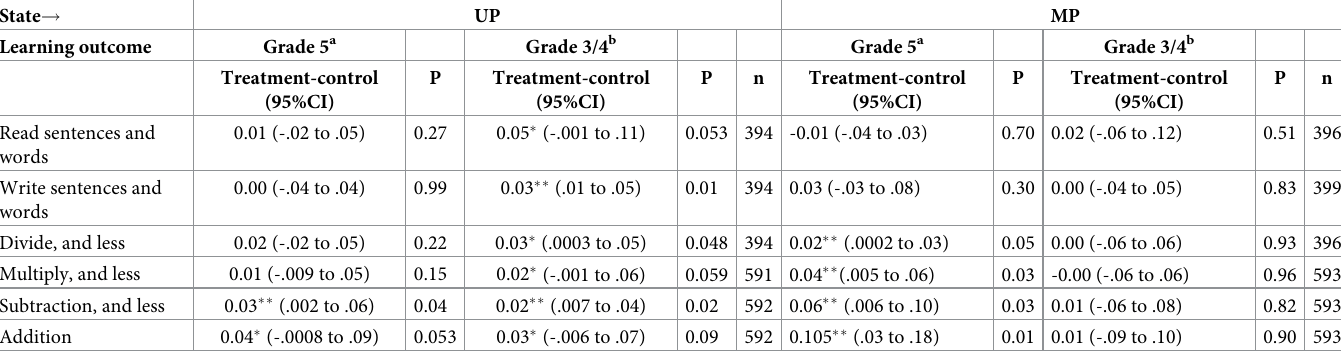
a Value represents coefficient on treatment variable for grade 5. 95% confidence interval in parentheses. b Value represents coefficient on treatment variable for grades 3 and 4. 95% confidence interval in parentheses. ��� P < 0.01, �� P < 0.05,